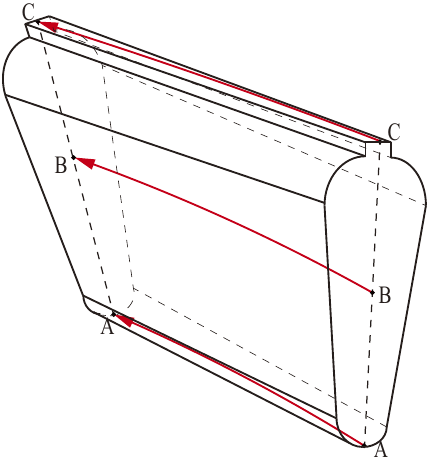
Figure 16. Thermal stress measurement paths of a bar.